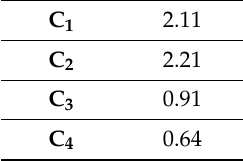
Table 2. Tuned coefficients in Equation (3) for